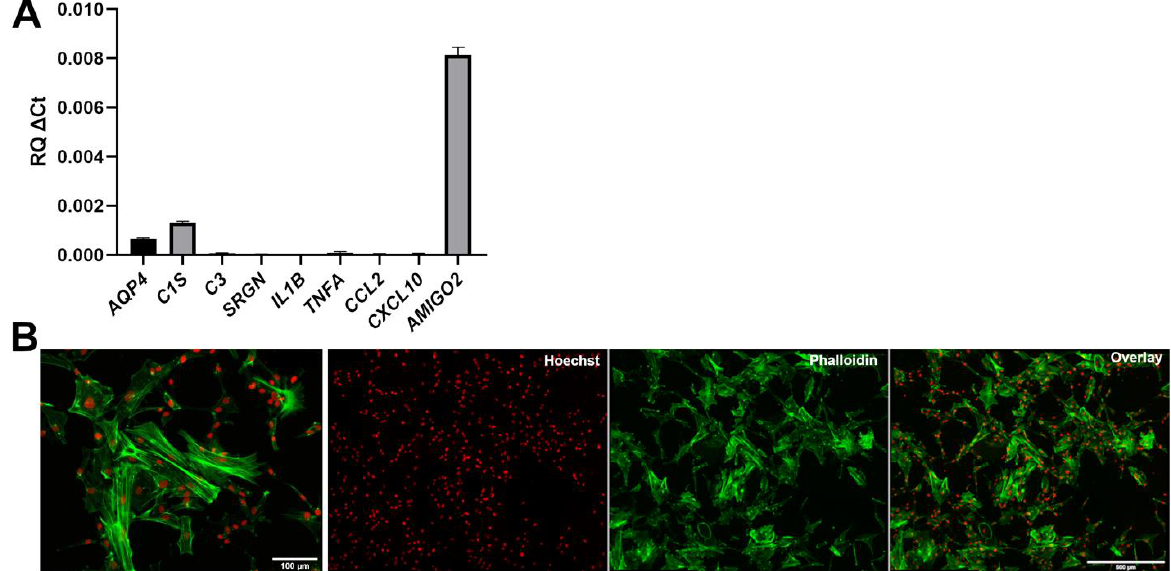
Figure 4. Lack of detectable signs of activation in human iPSC-derived ventral spinal astrocytes. ( A ) Real-time PCR analysis of the expression of a panel of astrogliosis markers. ( B ) Representative images, at different magnifications, of the actin cytoskeleton of induced astrocytes visualized by Alexa488-conjugated phalloidin staining (green); Hoechst counterstaining (red) is shown.